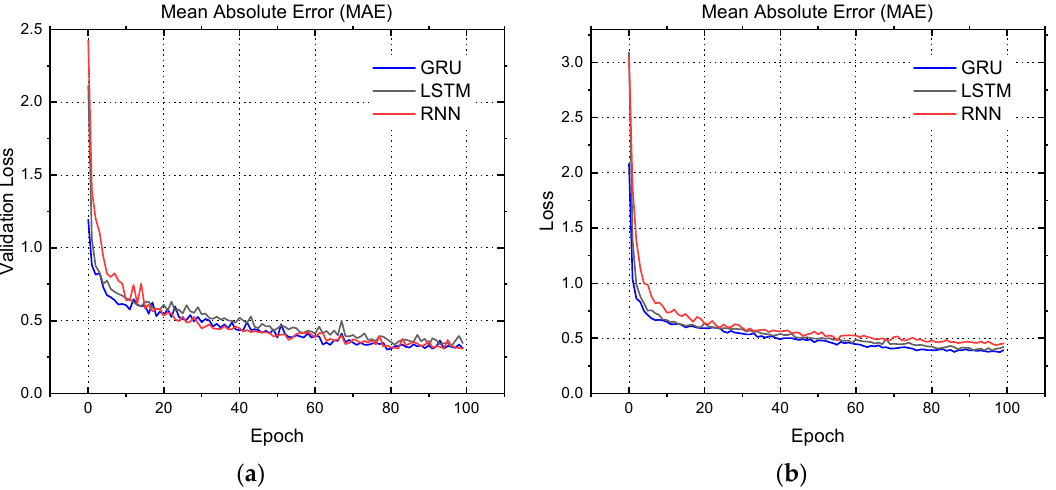
Figure 11. ( a ) MAE validation loss through GRU, LSTM and RNN; ( b ) Actual predicted MAE loss through GRU, LSTM and RNN.